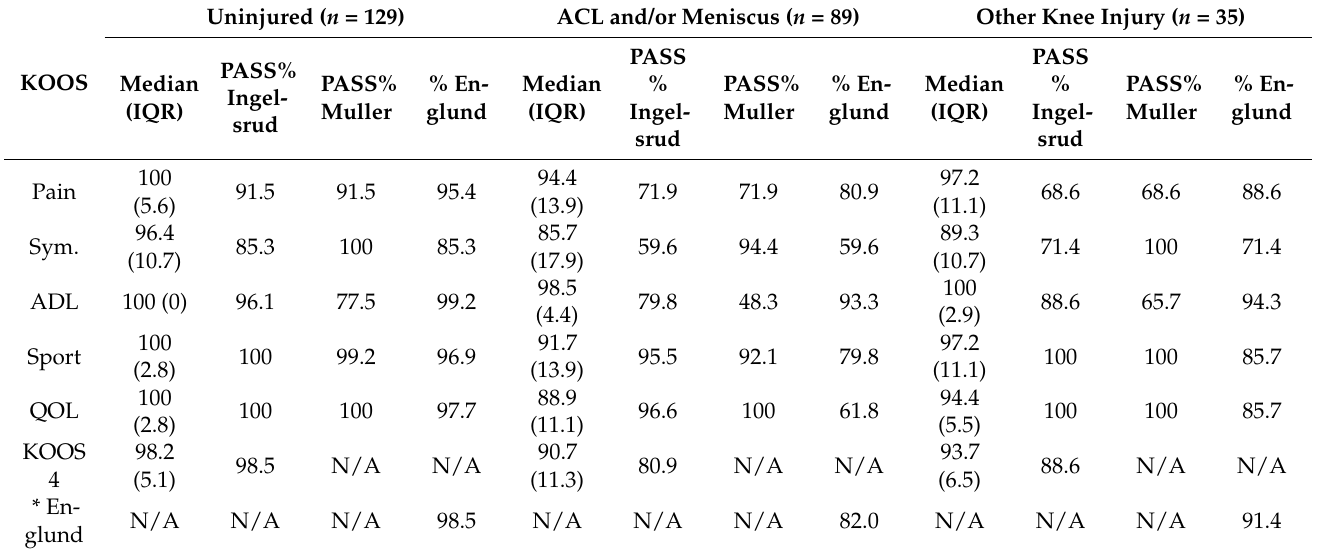
Table 2. Descriptive statistics and proportion of participants in the Alberta Youth Prevention of Early Osteoarthritis (PrE-OA) cohort meeting patient acceptable symptom state (PASS) for KOOS outcomes by Ingelsrud [10] and Muller [11] thresholds and proportion passing Englund [12] thresholds.